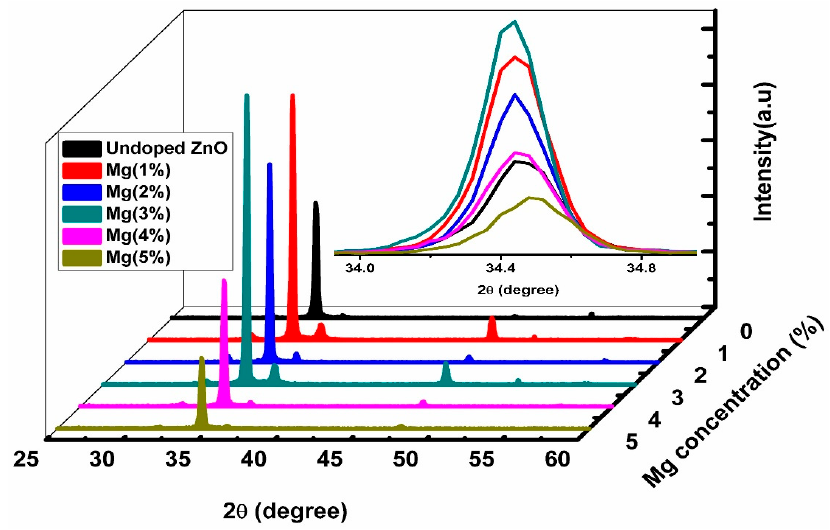
Figure 1. XRD patterns of the prepared undoped ZnO and Mg-doped ZnO nanorods via the hydrothermal method. The inset shows the shift in 2 θ in the c axis (002). Doping generally causes imperfections in the crystallization of host materials in the form of defects and oxygen vacancies, which change the structure and geometric param- eters of Mg-doped ZnO nanorods, as presented in Table 1. As can be noted in Table 1, the values of the lattice constants a and c were near the standard values for the hexagonal ZnO structure (a 0 = 3.25 Å and c 0 = 5.21 Å), and the c/a ratio proved that the prepared samples had nearly ideal wurtzite structures. The insignificant influence of the Mg con- tents on the lattice parameters of ZnO was probably because of the great solubility of the Mg ions in the lattice of ZnO [48]. The value of lattice strain showed an inverse trend in the grain size. The lowest strain value (7.91 × 10 − 4 ) at 3% Mg confirmed the high-quality epitaxial growth [51]. Table 1. Structural properties of undoped ZnO and Mg-doped ZnO nanorods with various doping concentrations. Sample 2 θ °